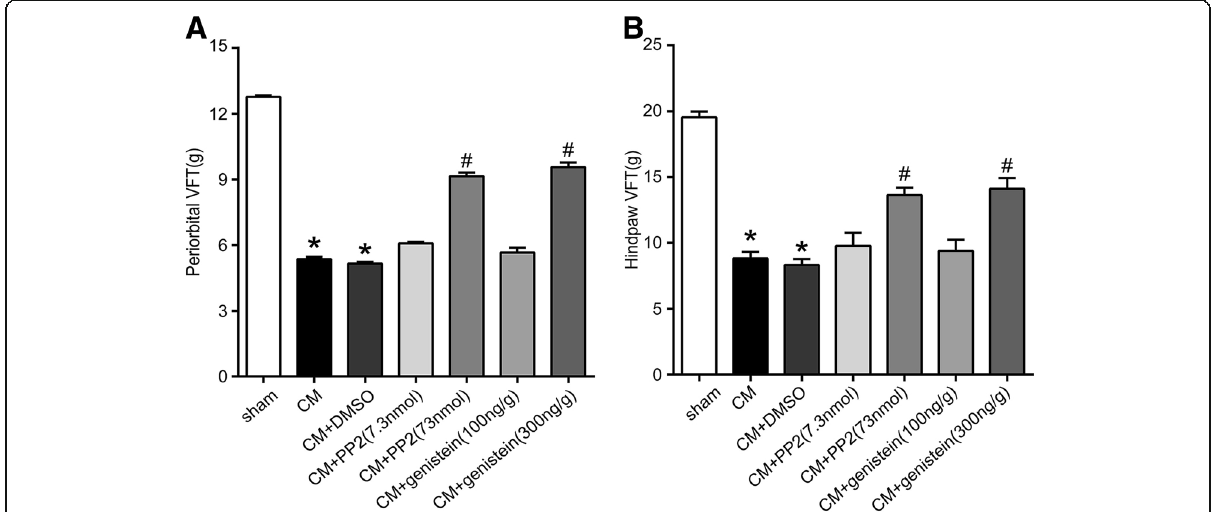
Fig. 3 Periorbital pressure and paw withdrawal thresholds after the administration of PP2 and genistein. a Periorbital pressure thresholds of the different groups. Compared with the sham group, the CM group showed a significant decrease in the periorbital pressure thresholds, but no significant difference in the von Frey test was found between the CM and CM + DMSO groups. Compared with that found for the CM + DMSO group, the administration of PP2 and genistein significantly increased the periorbital pressure thresholds. There was no significant difference in the von Frey test results among the CM + PP2 (7.3 nmol), genistein (100 ng/g) and CM + DMSO groups. The pain thresholds of the periorbital region obtained in the CM + PP2 (73 nmol) and genistein (300 ng/g) groups were significantly increased compared with those in the CM + DMSO group. b Paw withdrawal thresholds of the different groups. Compared with the sham group, the CM group showed a significant decrease in the paw withdrawal thresholds, but there was no significant difference in the von Frey test results between the CM and CM + DMSO groups. Compared with that found for the CM + DMSO group, the administration of PP2 and genistein significantly increased the periorbital pressure thresholds. There was no significant difference in the von Frey test results among the CM + PP2 (7.3 nmol), genistein (100 ng/g) and CM + DMSO groups, but there were significant differences in the von Frey test results mong the CM + PP2 (73 nmol), genistein (300 ng/g) and CM + DMSO groups ( n = 10, each group, * P < 0.01 compared with the sham group, # P < 0.01 compared with the CM + DMSO